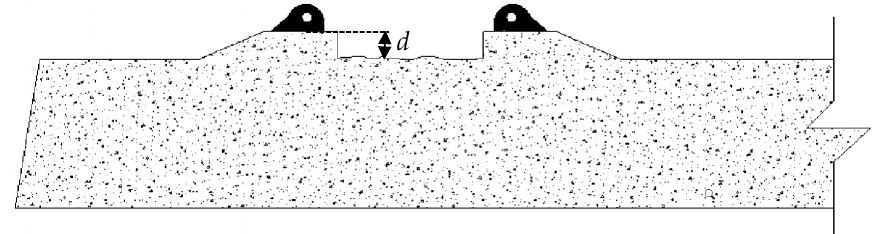
Figure 15. Detail of the Rail Seat Abrasion.